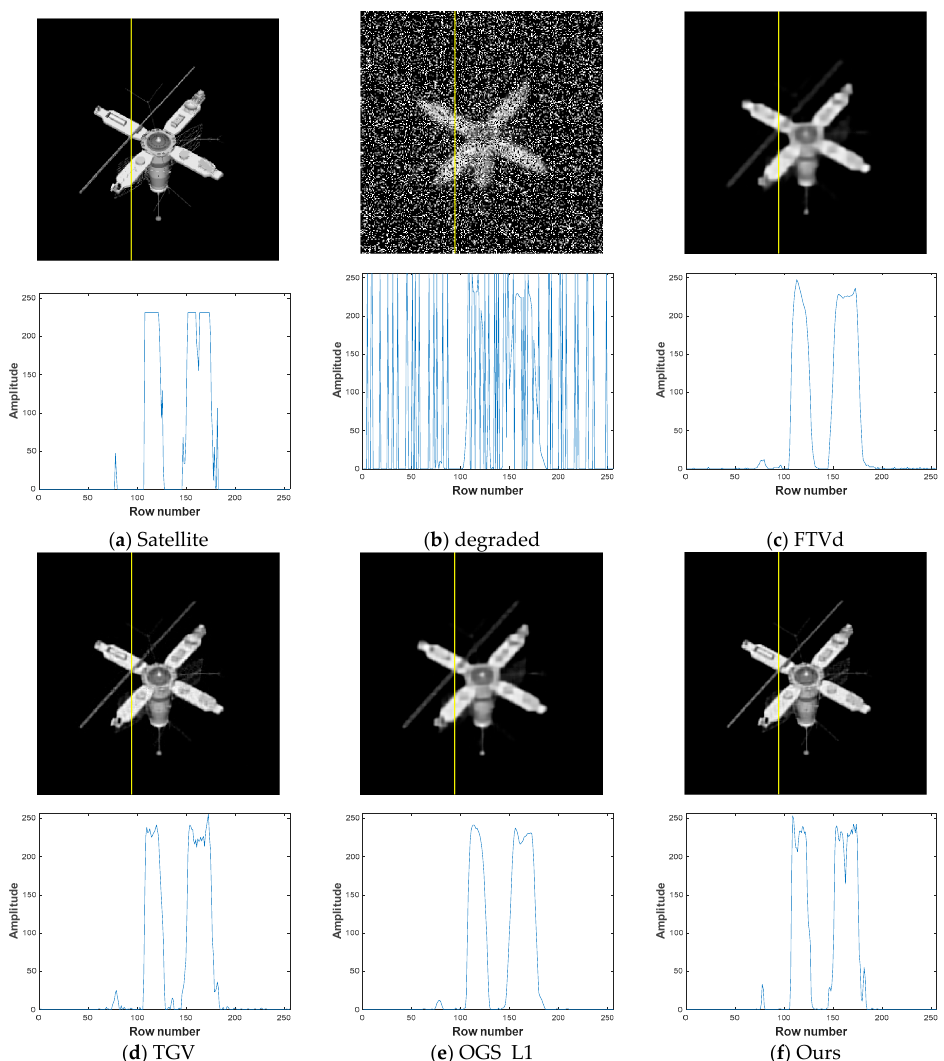
Figure 9. Comparison of the proposed model and several advanced models in terms of the 100th-channel data of the reconstructed satellite images. ( a ) refers to the grayscale values of the 100th pixel channel in the original satellite image, with the yellow vertical line on the figure indicating the 100th-channel position. ( b ) refers to a blurred image owing to convolution with a G 9 × 9, σ = 5 blur kernel at impulse noise level of 40%. ( c – f ) depict images with grayscale values of the 100th channel recovered by the FTVd, TGV, OGS_L1, and proposed algorithms, respectively.